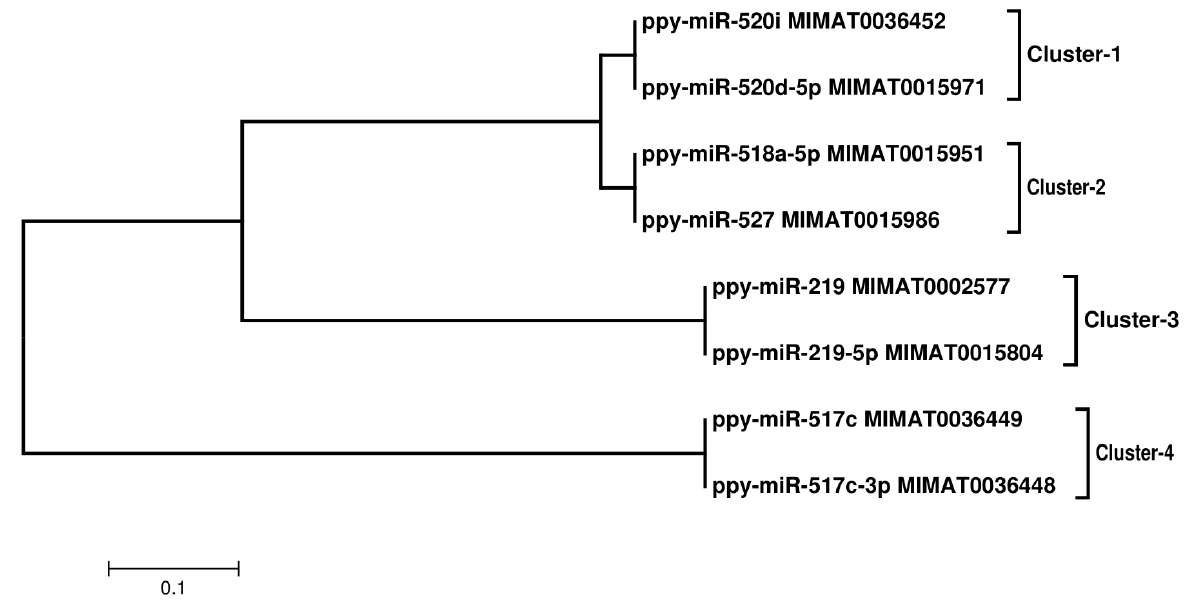
Figure 3. Illustrate evolutionary relationships of taxa for Pongo pygmaeus . The analysis involved 8 nucleotide